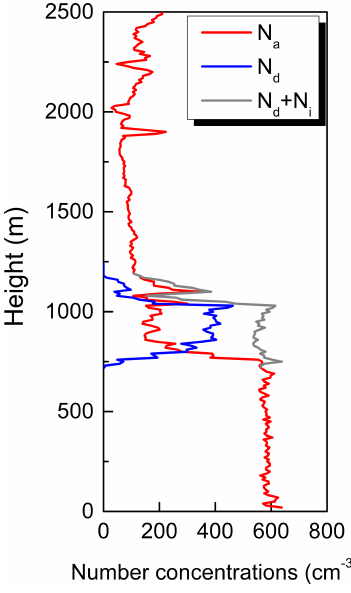
Figure 5. Vertical profiles of number concentrations of aerosols ( N a ), cloud droplets ( N d ), and total in-cloud particles ( N d + N i ) during the flight on 18